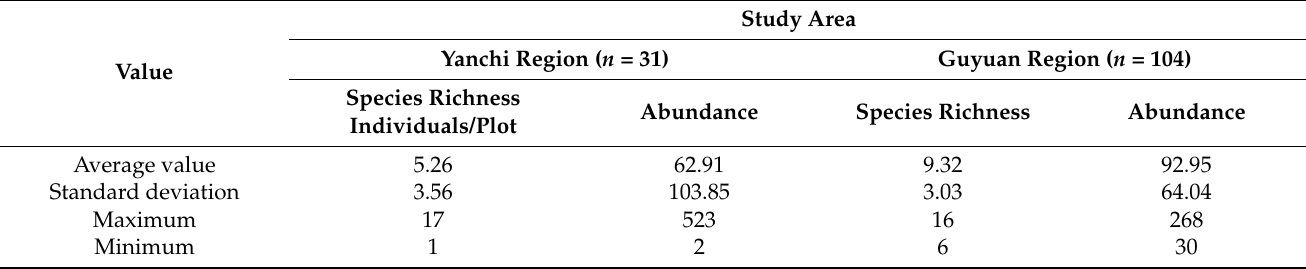
Table 1. The average species richness and abundance of carabid beetle in Yanchi and Guyuan region (mean number/sample plot, n presents sampling plot).